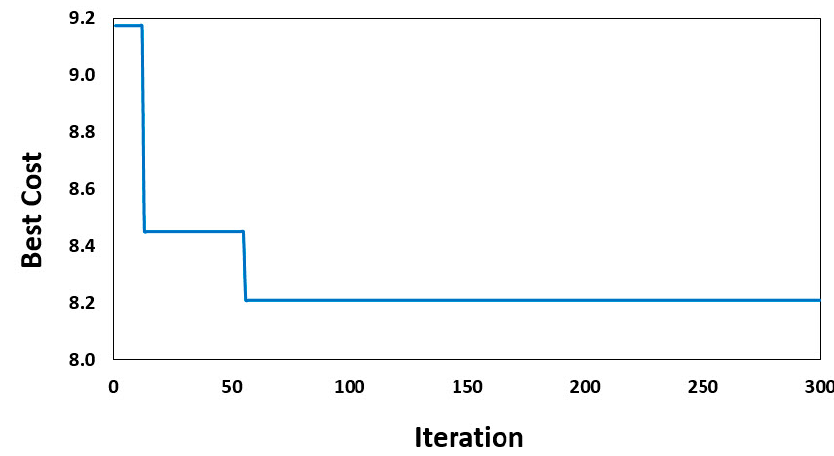
Figure 4. Best cost-per-iteration provided by the HS algorithm. Figure 4. Best cost ‐ per ‐ iteration provided by the HS algorithm. Table 3. Optimization and clustering of the considered dataset by the HS